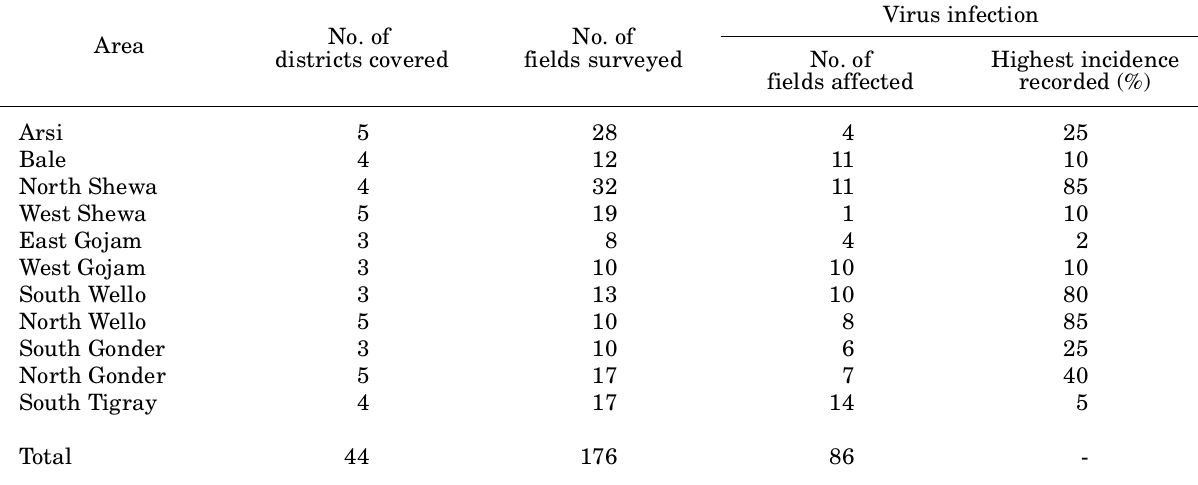
Virus infection